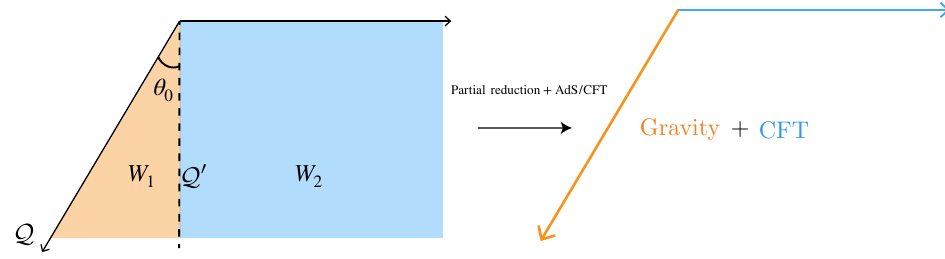
Figure 4 . 2D effective description of DES model by performing partial reduction for W 1 and AdS/CFT for W 2